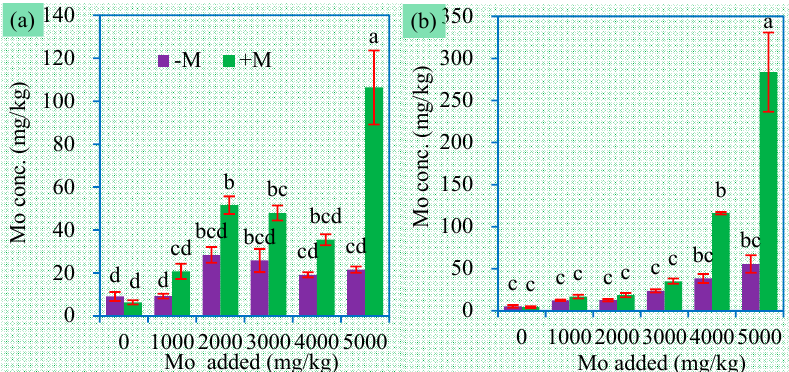
Figure 3. Shoot ( a ) and root ( b ) Mo concentrations (mean ± SE, n = 4) of sweet sorghum exposed to different concentrations of Mo. -M and +M represent non-AM inoculation and inoculation with Claroideoglomus etunicatum BEG168, respectively. Different letters over the bar represent significant differences between the means among different treatments using one-way ANOVA followed by Duncan’s multiple range test ( p < 0.05). Two-way ANOVA results for shoot Mo concentrations: AM inoculation: F = 60.9**, Mo: F = 23.3**, AM×Mo: F = 13.0**; two-way ANOVA results for root Mo